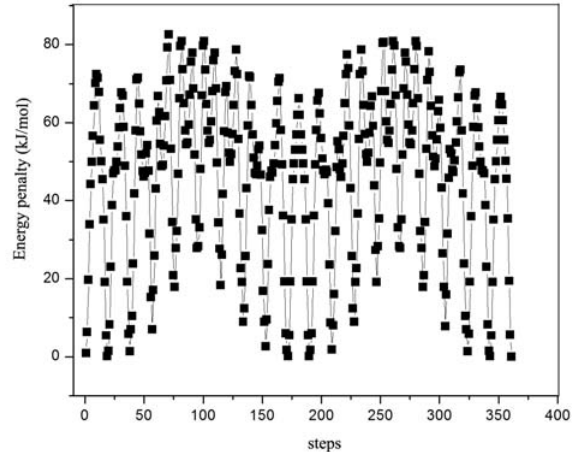
Fig. 2. 2D PES scan plot of the benzocaine molecule with energy penalty associated with each